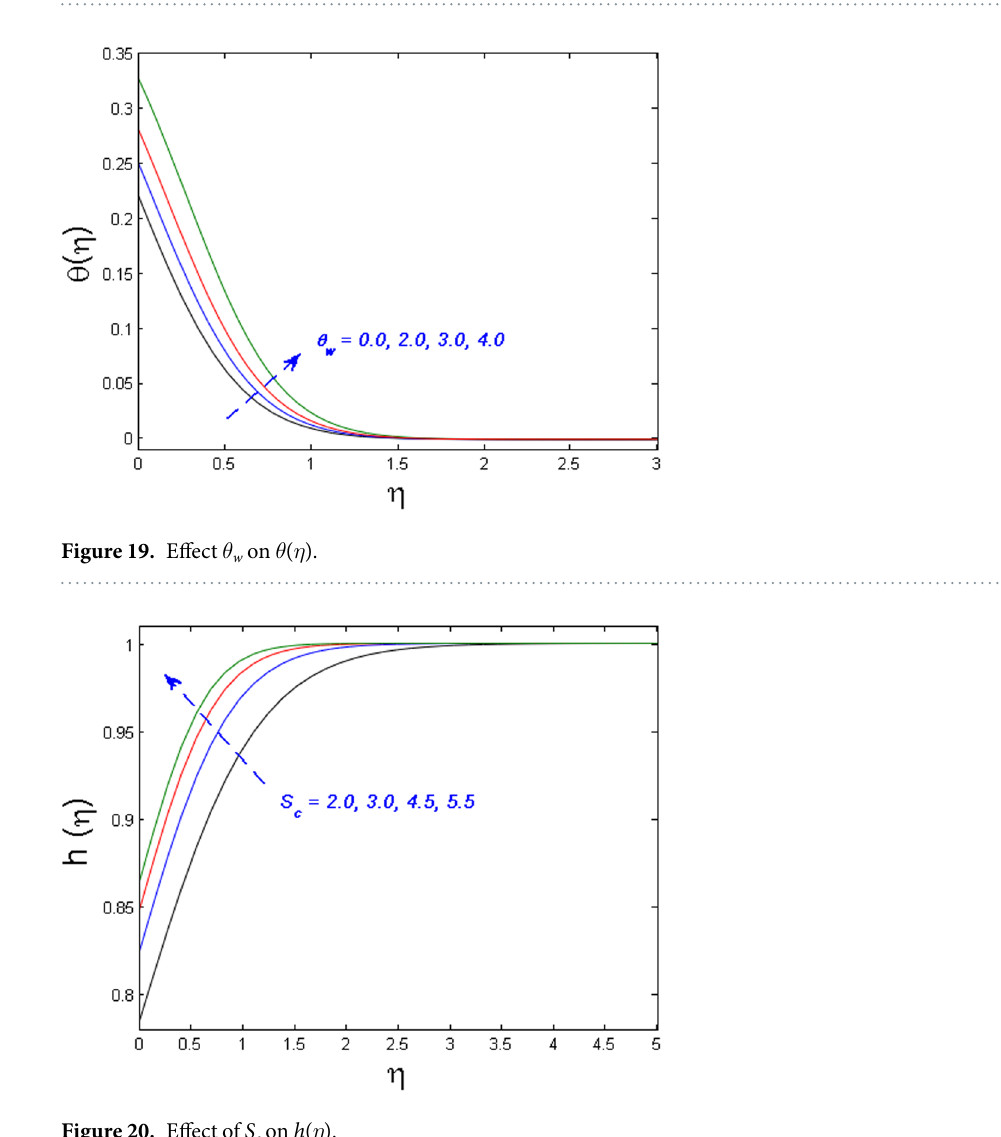
Figure 18. Effect of R d on θ ( η ).